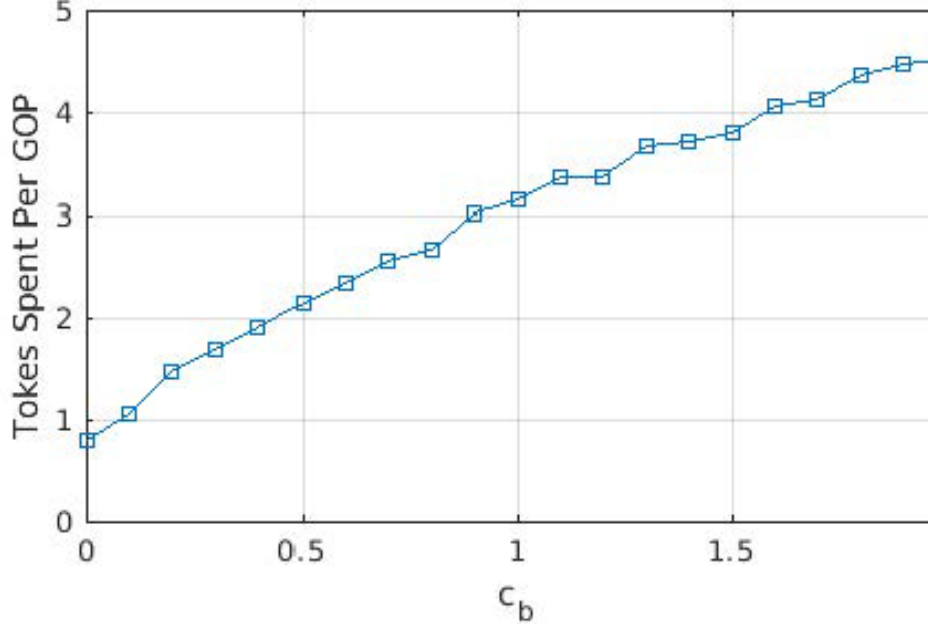
Figure 9. Tokens paid per GOP for different values of c b when transcoding is disallowed.